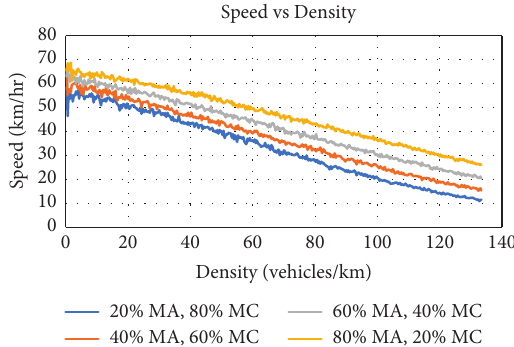
Figure 19: Speed vs. density fundamental diagrams for different compositions of MA and MC.